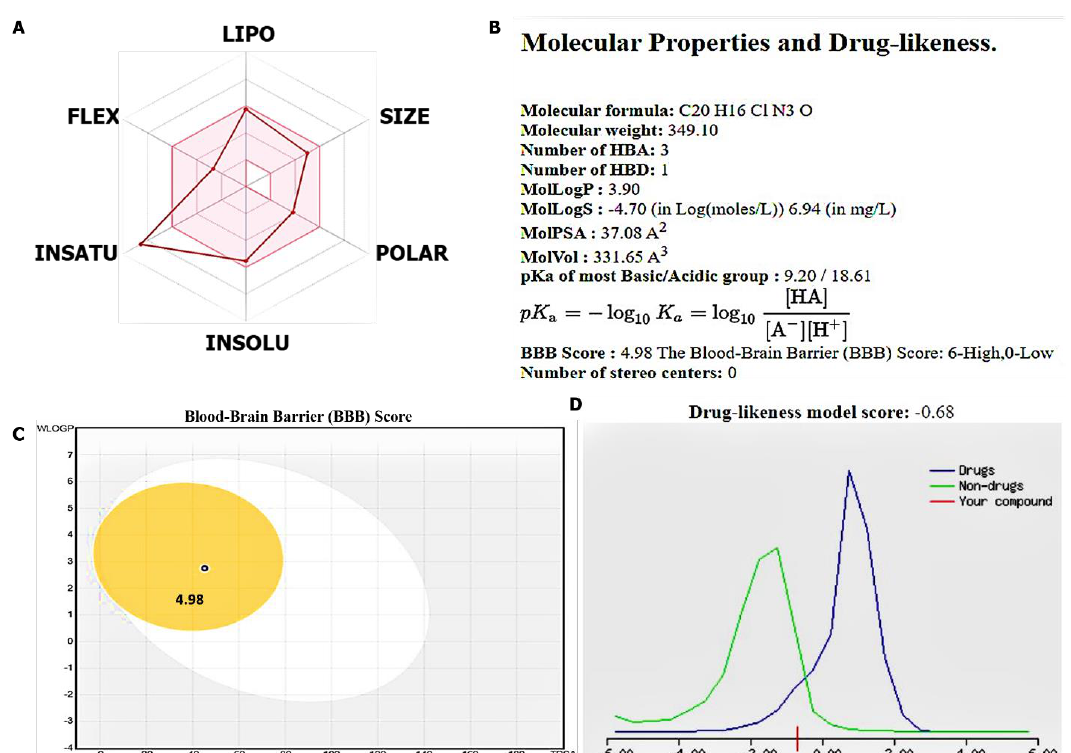
Figure 3. SJ10 passed the required physicochemical properties, medicinal chemistry, pharmacoki- netics (PK), and drug-likeness criteria. ( A , B ) Structure of the SJ10 (NSC772862) small molecule, bioavailability radar (BA), displaying the six physicochemical properties of absorption including lipophilicity (XLOGP3 = 3.90), molecular weight (349.10 g/mol), polarity (PSA = 37.08 Å 2 ), solubility (Log S (ESOL) = − 4.7), flexibility (rotation = 4), saturation (fraction Csp3 = 0.2), and pKa of the most basic or acidic group (= 0.5) of the SJ10 compound. In addition, the SJ10 compound demonstrated a highly-probable GIA absorption, bioavailability score (55%) and good synthetic accessibility (2.89). ( C ) The compound passed the blood–brain barrier (BBB) with a score of 4.98, and further displayed a drug-like model score of − 0.68. A structural characterization of the compounds was done with the help of spectroscopic studies including IR, proton NMR, 13C NMR, MS, and elemental analysis ( D ). 3.3. CCNB1/CDC42/MAPK7/CD44 Oncogenic Signatures Are Overexpressed in